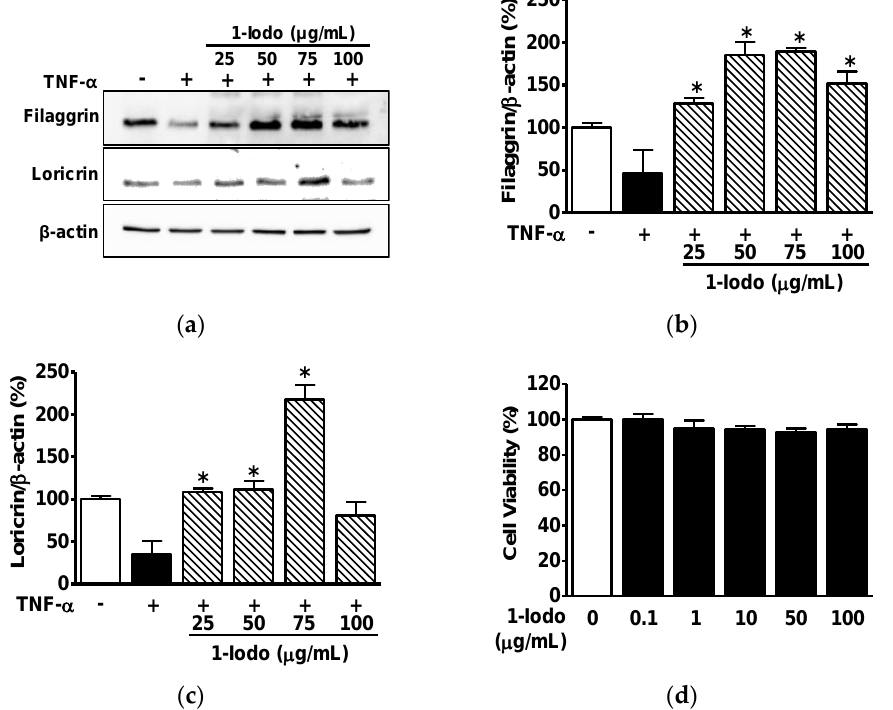
Figure 3. Effects of 1-iodohexadecane on the expressions of skin barrier-related proteins in TNF- α -stimulated keratinocytes. ( a – c ) Expressions of skin barrier-related proteins. HaCaT cells were cultured at 37 ◦ C for 36 h in DMEM in the presence or absence of TNF- α (5 ng/mL) with or without 1-iodohexadecane (1-Iodo; 25–100 µ g/mL). Cell lysates were immunoblotted with the indicated antibodies. ( a ) Representative images. ( b , c ) Results for filaggrin ( b ; n = 3) and loricrin ( c ; n = 3) were obtained from panel A. ( d ) Cell viabilities. HaCaT cells were treated with 1-Iodo (0.1 – 100 µg/mL) for 36 h, and viabilities were measured using an EZ-CyTox kit ( n = 5). Responses are expressed as percentages of untreated cells. The results are represented as means ± SEMs. * p < 0.05 vs. TNF- α alone-stimulated cells.